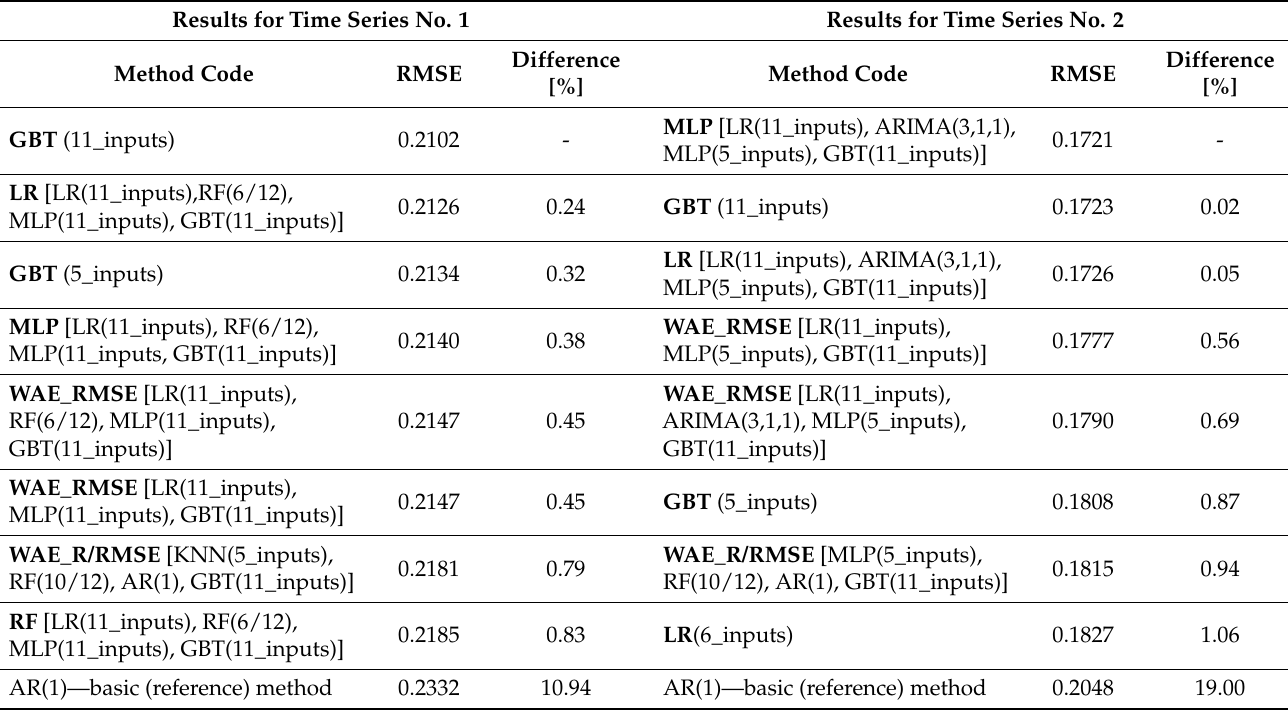
Table 10. Summary comparison—the best eight methods chosen from single and ensembles methods for both time series sorted in descending order by RMSE and the basic (reference) method. Results for Time Series No. 1 Results for Time Series No.